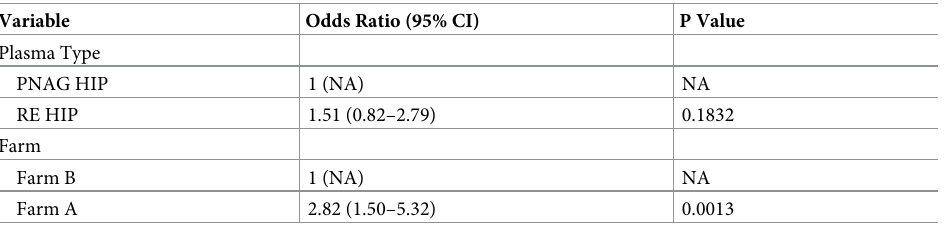
Odds ratios (and 95% CIs) estimated using logistic regression for the outcome of pneumonia attributed to R . equi among 233 foals transfused with either R . equi hyperimmune plasma (RE HIP) or β -(1 ! 6)-linked poly- N -acetyl- glucosamine hyperimmune plasma (PNAG HIP) at both Farm A and Farm